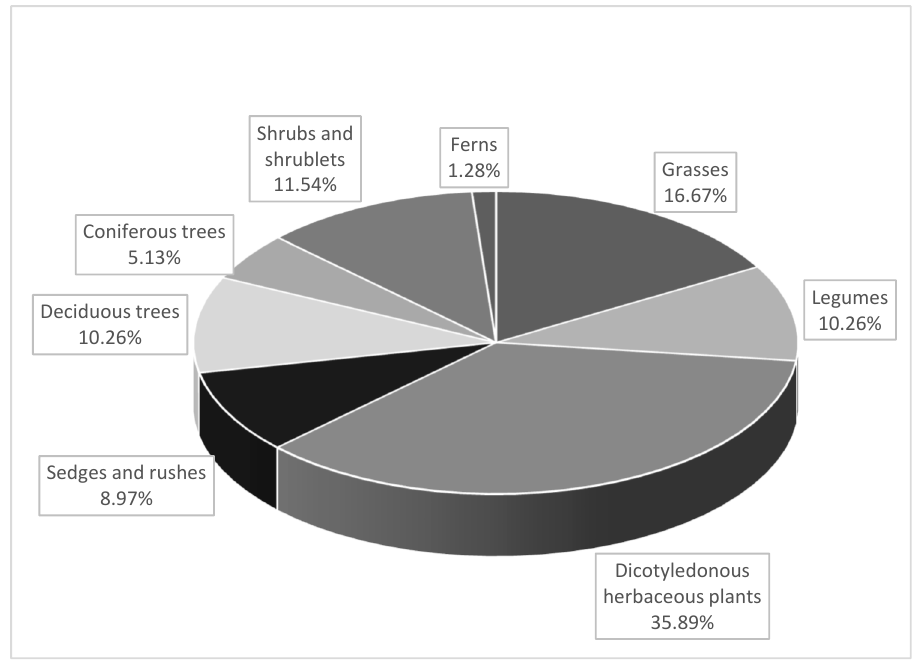
Figure 2. Structure of plant groups in the conventional farm feeding grounds. Table 2. Nutritional value of plants growing in the farm feeding grounds, expressed as a fodder value score (FVS).